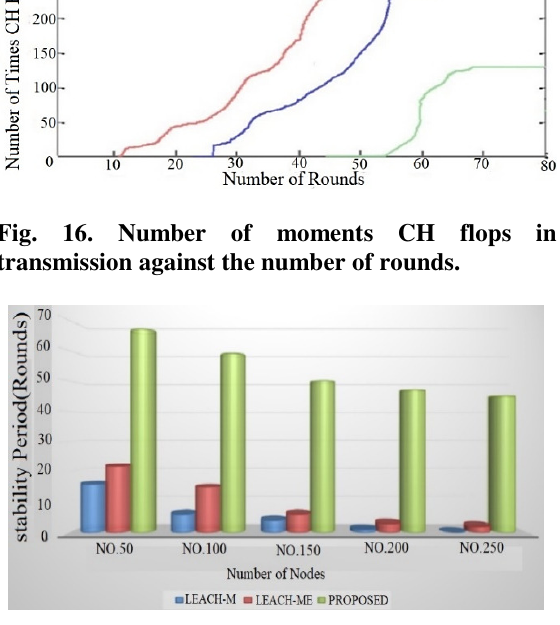
Fig. 17. Stability Period Subject to Different Number of Nodes.